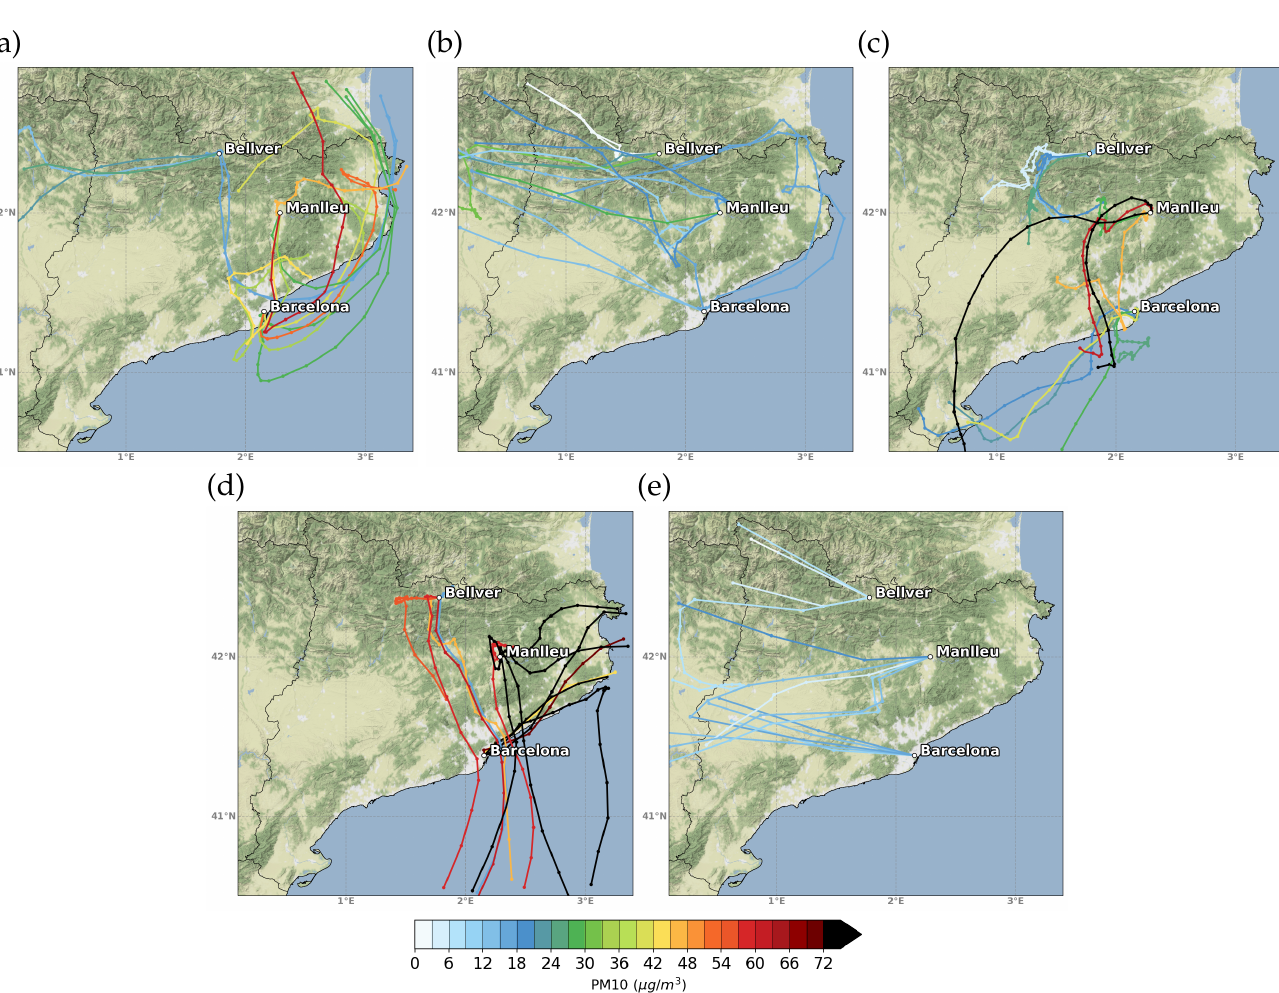
Figure 5. Representative hourly air-mass backward trajectories at 100 m related with PM 10 concentrations automati- cally measured at the station the hour of arrival. ( a ) 02/08/2019, ( b ) 16/11/2019, ( c ) 20/11/2019, ( d ) 18/12/2019, and ( e )